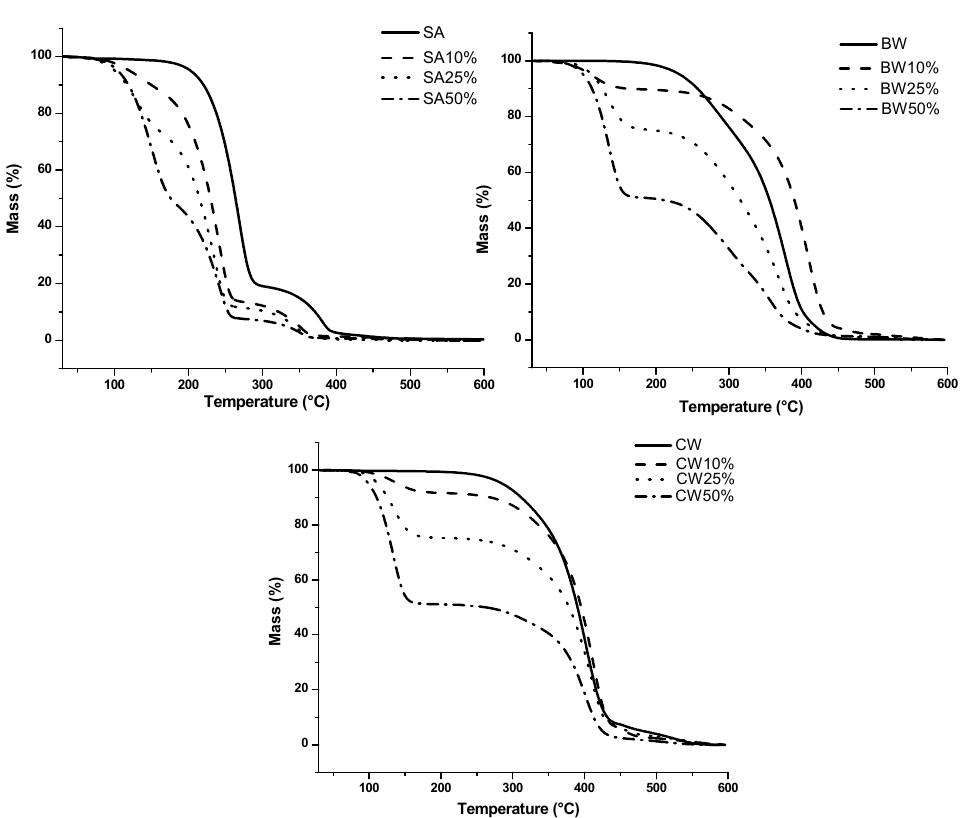
Figure 1. Thermogravimetric curves of the stearic acid (SA, upper left), beeswax (BW, upper right) and carnauba wax (CW, bottom) in comparison to their binary mixtures containing 10%, 25% and 50% of carvacrol (see Table 1 for composition).